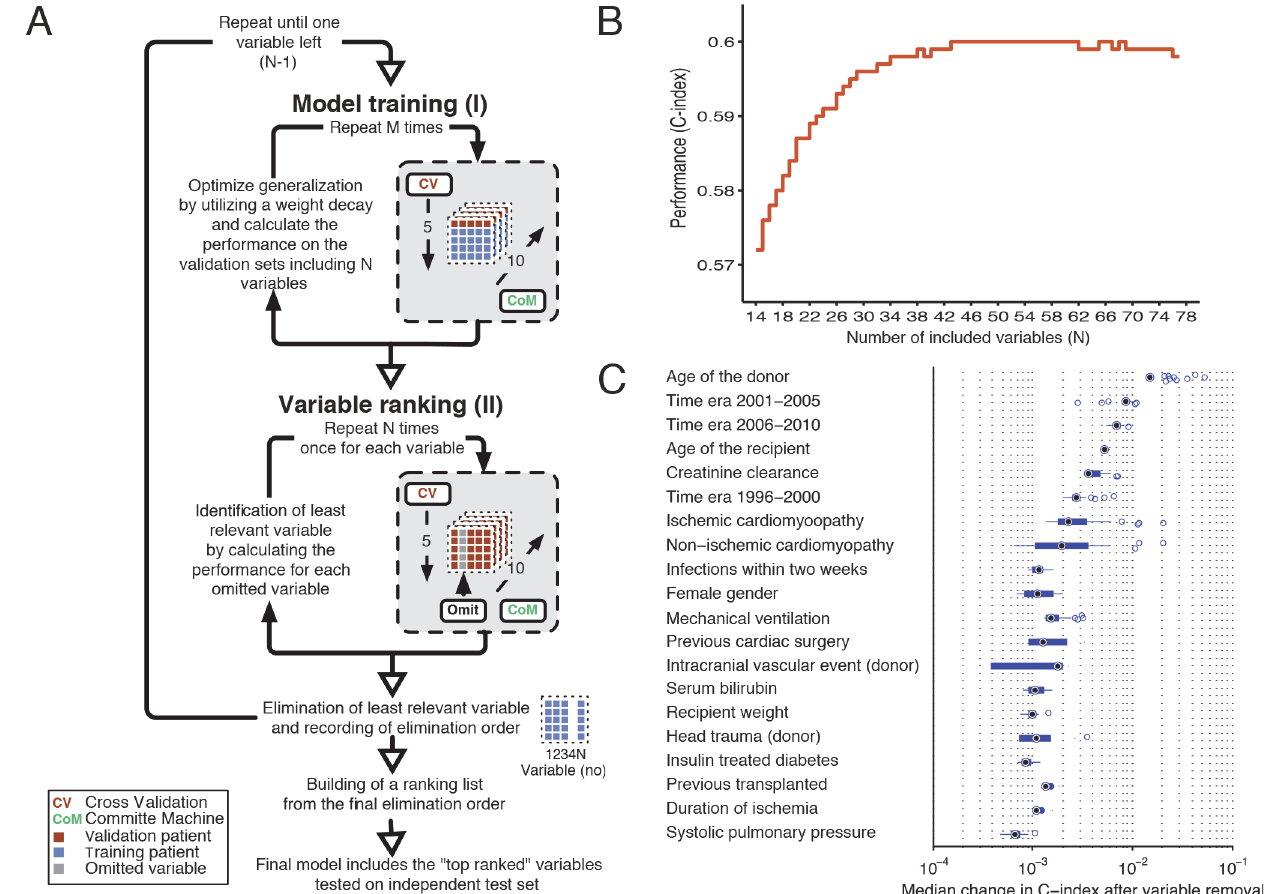
Fig 1. Schematic illustration of the variable-ranking process for the derivation cohort. Panel (A). Step I: training of the survival model using fivefold cross-validation and a committee machine with 10 members. Step II: variable-ranking using the trained survival model from step I. Each variable is omitted from the model and the decrease in performance is recorded. The variable resulting in the least reduction in performance is removed. Steps I – II are repeated until only one variable is left. A ranking list is constructed using the elimination order. Panel (B). Performance as a function of number of variables included. The C-index is plotted against the number of input variables, where order is in terms of decreasing importance. Variables with a high index number are least important. Panel (C). The relative importance of 20 of the 43 top-ranked variables. The box plot for each variable is created from the series of C-index changes that was the result of removal of the variable during the ranking